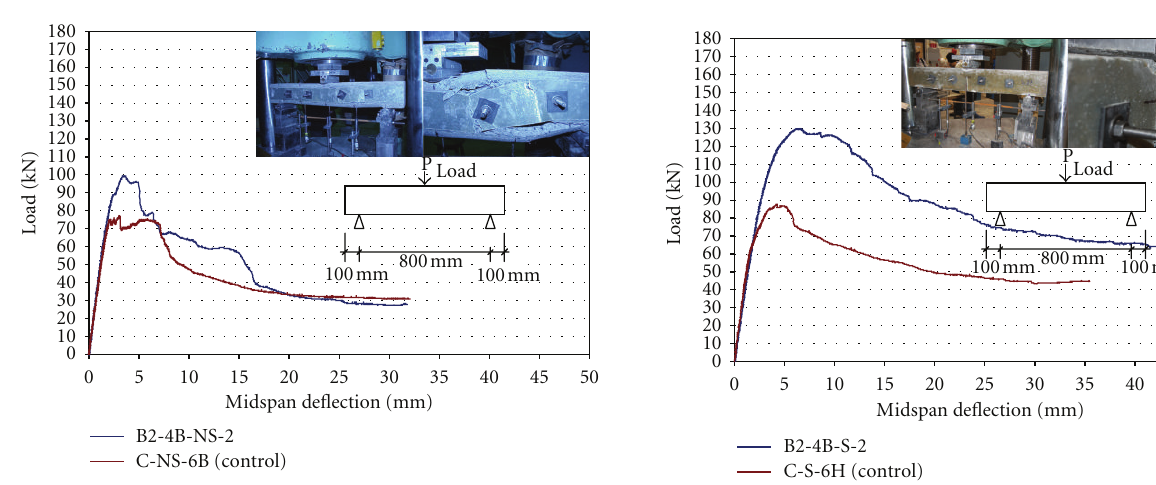
Figure 27: Load versus midspan deflection of RC beam B2-4B-S-2.